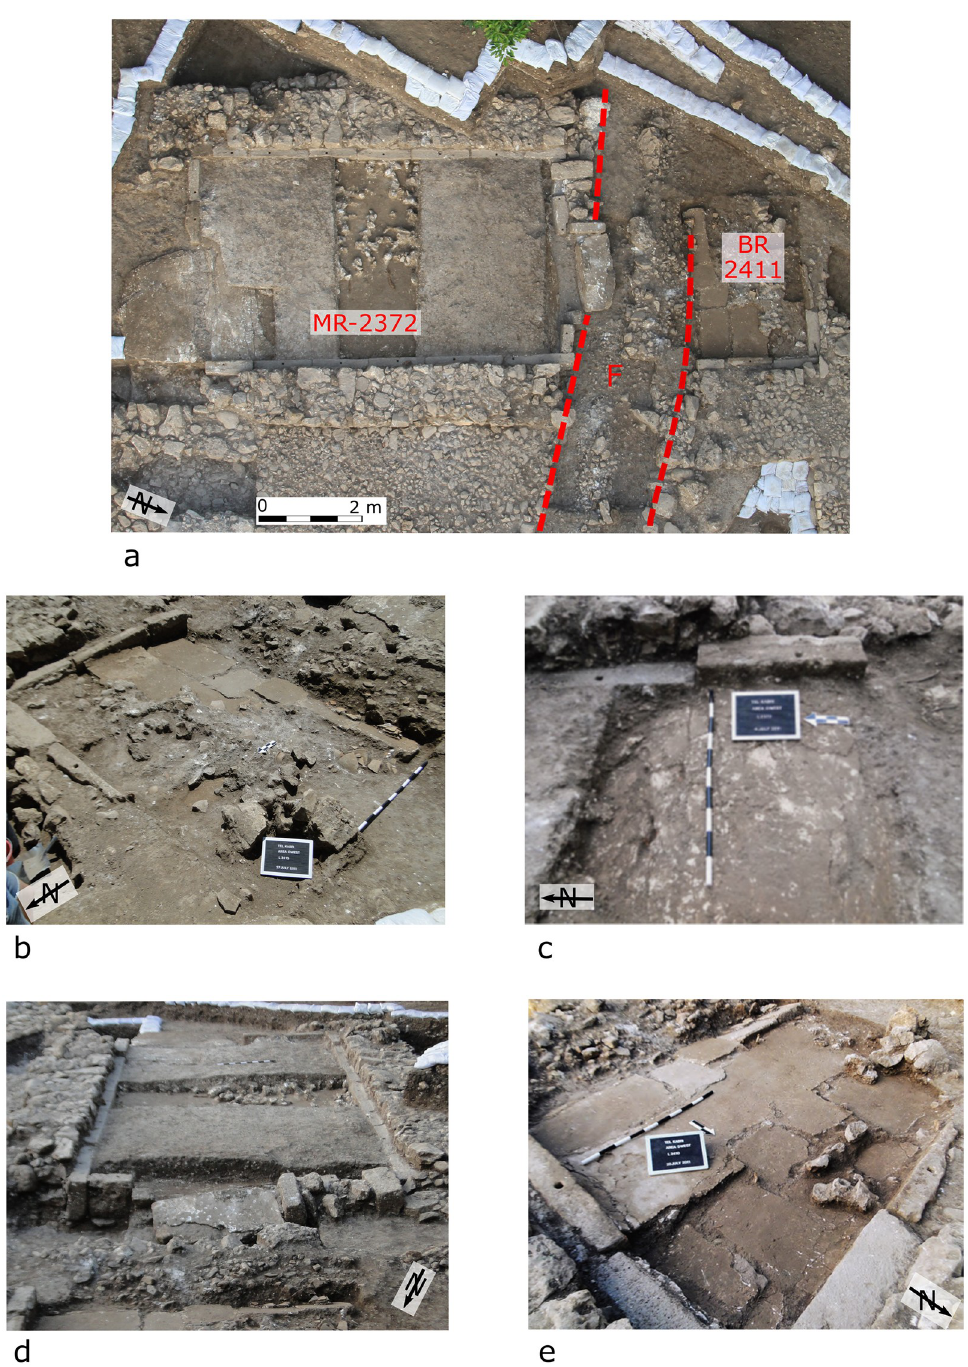
Fig 3. The Orthostat Building. Each black or white segment on the scale-sticks represents 10 cm. (a) Aerial view showing the Main Room (MR), Back Room (BR), and Trench (T), which is denoted by dashed red lines. Notice that the southern side of the trench is partially obscured by a large stone block, whose flat upper side would have once served as a threshold leading into the back room, but which has now collapsed into the trench. Photo: Griffin Aerial Imaging. (b) The backroom (2411) covered in collapsed mudbrick and plaster. (c) Step or displacement in the floor of the Orthostat Building, just inside the entrance. One of the offset orthostats is visible at the top of the image. (d) The Main Room looking south and showing unbroken warped cross-walls; i.e., with a rise visible in the height of the walls. At the bottom of the image, wall 2404 and the threshold leading into the back room are visibly collapsed and tilting into the trench. (e) The backroom cleared of all rubble shown in Fig 3b, showing the broken and sloping plaster